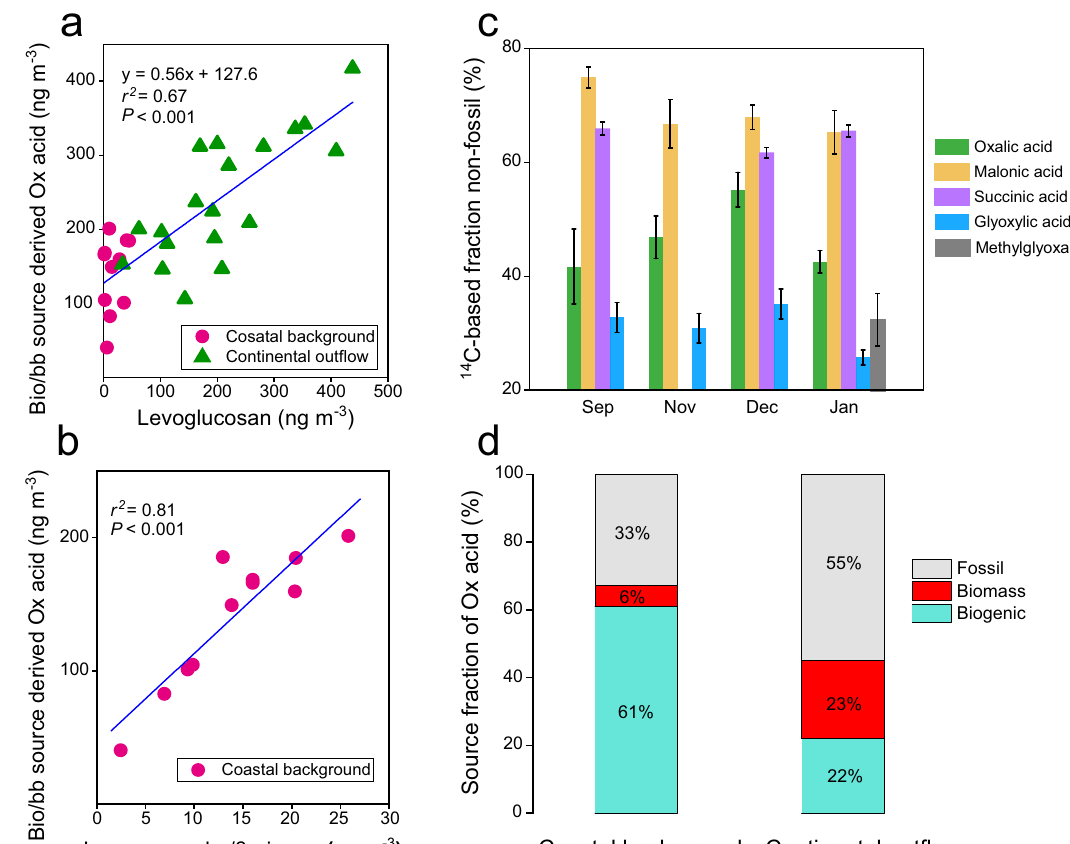
Fig. 4 | Radiocarbon-based source apportionment of dicarboxylic acids and related compounds. a Relationships between biogenic/biomass burning (bio/bb) source-derived oxalic acid vs. levoglucosan. b Relationships between bio/bb source-derived oxalic acid vs. biogenic secondary organic aerosol (SOA) tracer (include isoprene SOA tracers and α / β − pinene SOA tracers; Supplementary